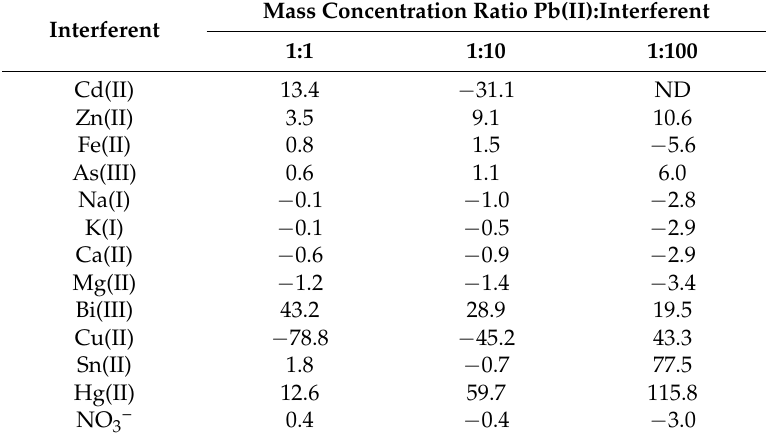
Table 2. The influence of different compounds on the Pb(II) peak height: the values are calculated as (cid:16) I (cid:17) interferent − I Pb ( II ) · 100%, where I the change in % = interferent and I Pb(II) are the stripping signals for Pb(II) I Pb ( II ) at 200.0 µ g/L, with and without the presence of interferent, respectively, in 0.01 M HCl solution [15]. Measurements were performed using the same experimental conditions as for Figure 2. Mass Concentration Ratio Interferent